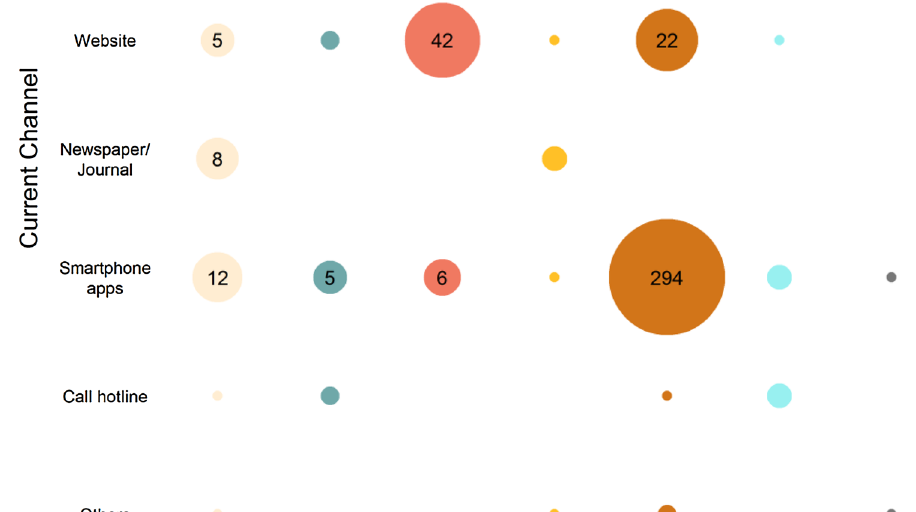
Fig. 1 Comparison between current and preferred channels of weather information acquisition in Hong Kong, January/February 2016. Note The rows refer to the current channels and the columns refer to the preferred channels. Larger circles indicate larger numbers of people. The number in each circle is the actual frequency. The circles on the main diagonal represent those who were using their preferred channel. Numbers less than 5 were not shown in the graph